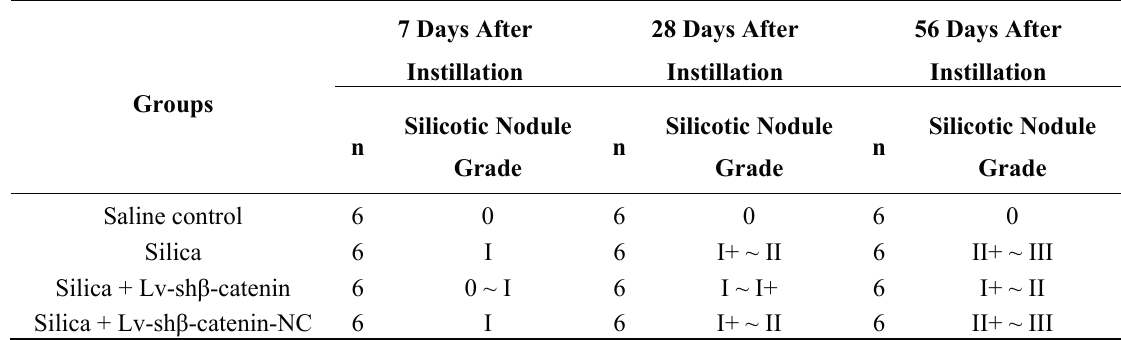
Figure 5. HE staining for histopathologic changes in mice lungs (×400). Table 2. Silicotic nodule grade of the mouse lungs in each